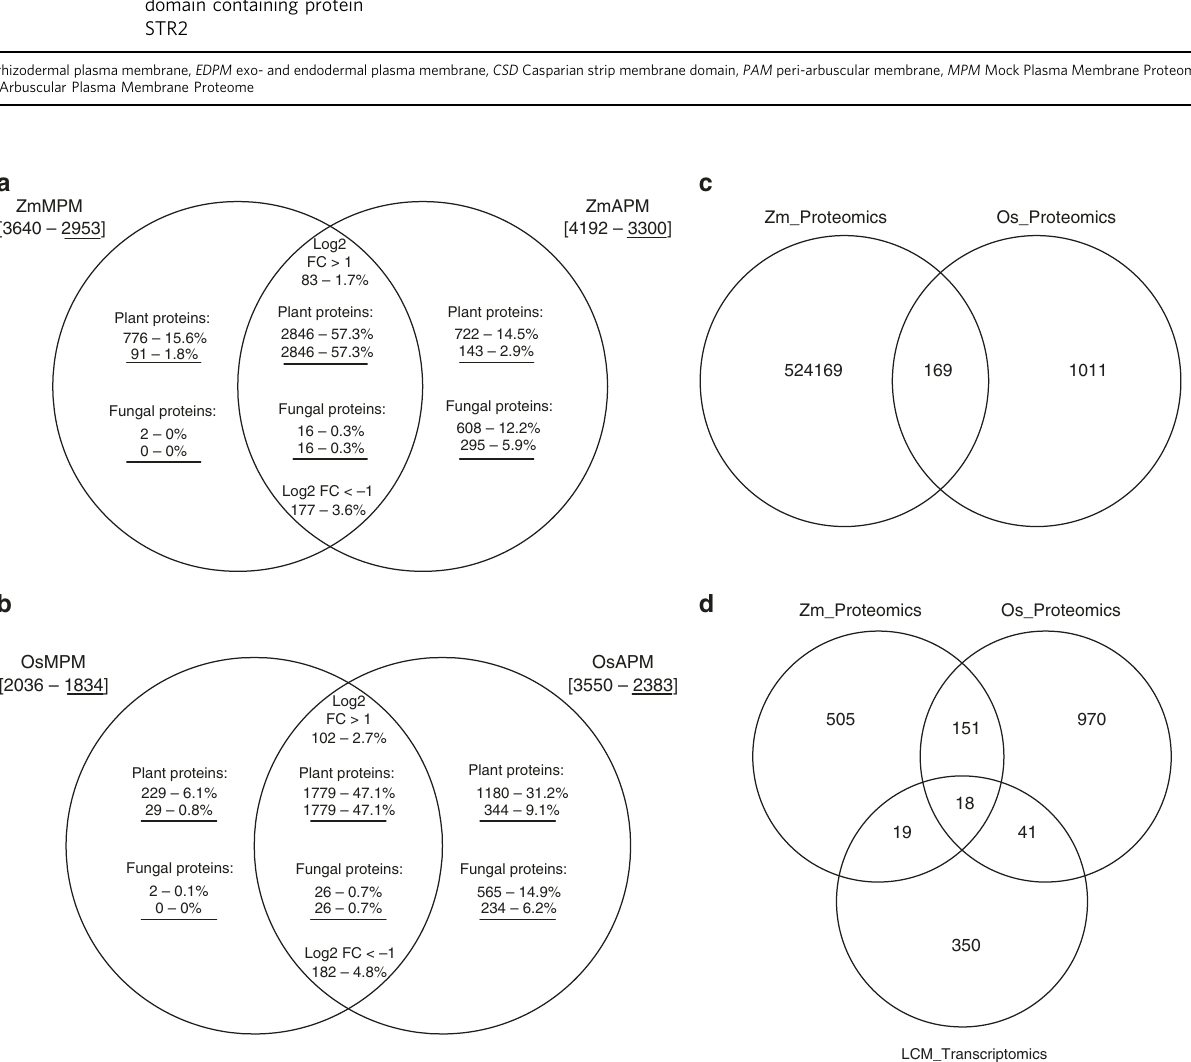
Fig. 1 Venn diagrams of maize and rice proteome and LCM transcriptome analyses. a Number of identi fi ed proteins detected in maize mock control (ZmMPM), arbuscule-containing (ZmAPM) or in both root samples. b Number of identi fi ed proteins detected in rice mock control (OsMPM), arbuscule- containing (OsAPM) or in both root samples. c Number of AM symbiosis-associated membrane proteins identi fi ed from maize (ZmAPM) or in rice (OsAPM) or in both species. d Number of AM symbiosis-associated proteins from maize (ZmAPM) or rice (OsAPM) or arbuscule-associated LCM transcripts (LCM_transcriptomics). Numbers in brackets indicate the total number of detected proteins; underlined numbers indicate the quanti fi ed proteins. The table shows the numbers of all plant or fungal proteins